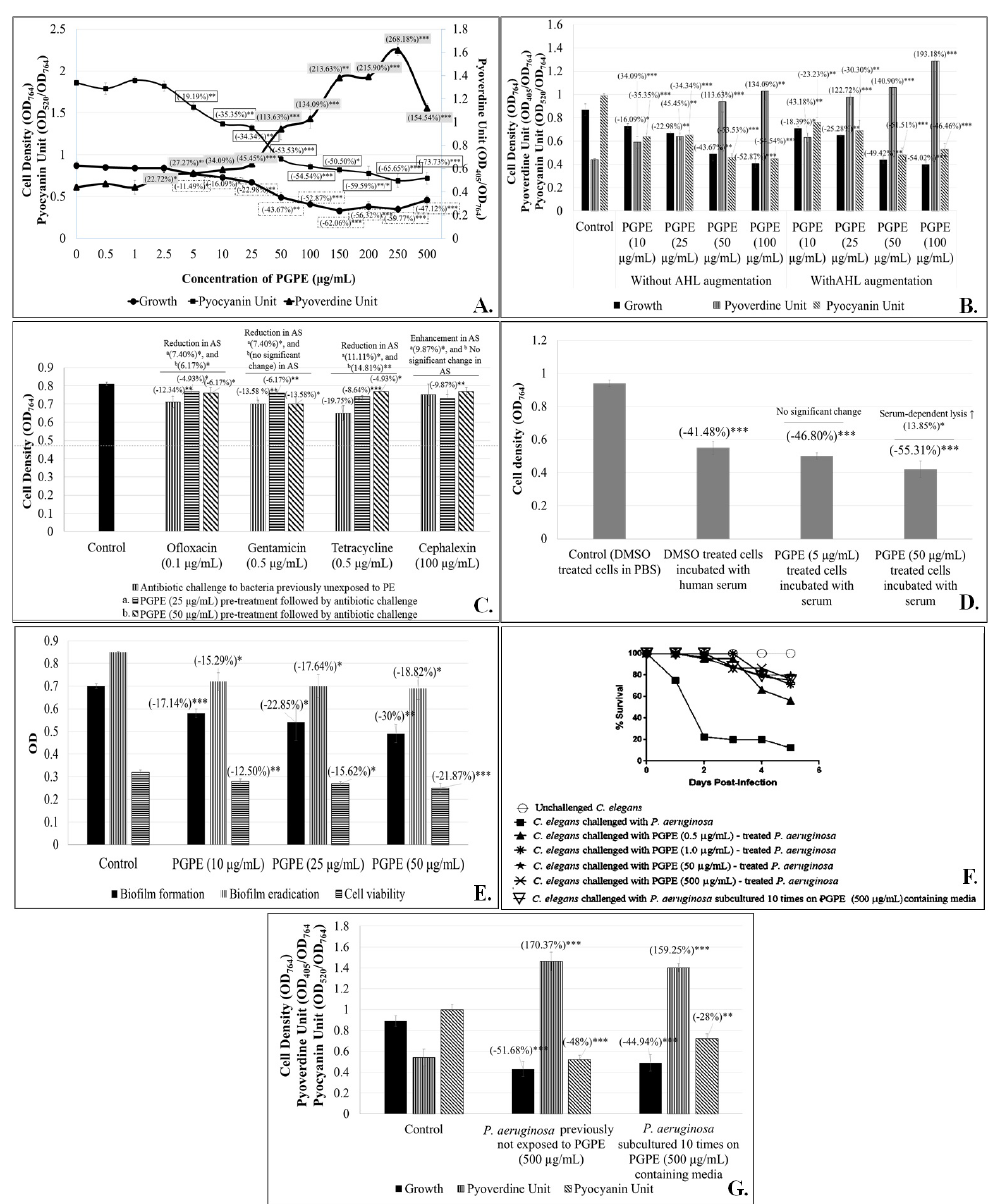
Figure 2. Effect of PGPE on various traits of P. aeruginosa, in vitro . ‘Control’ in this figure is the vehicle control (0.5%v/v DMSO), which did not exert any effect on growth and pigment production of P. aeruginosa . ( A ) Effect of PGPE on growth and QS-regulated pigment production in P. aeruginosa: Bacterial growth was measured as OD ; OD of pyoverdine was measured at 405 nm, and Pyoverdine Unit was 764 calculated as the ratio OD /OD (an indication of pyoverdine production per unit of growth), Pyocyanin Unit was calculated as the ratio 405 764 OD /OD (an indication of pyocyanin production per unit of growth); Catechin (50 µg/ml) inhibited pyoverdine and pyocyanin production 520 764 by 17.13±0.06% and 23.65±0.04% respectively, without affecting the bacterial growth. ( B ) PGPE acts as a signal-response inhibitor against P. aeruginosa . ( C ) P. aeruginosa challenged with antibiotics following pre-treatment with PGPE. ( D ) PGPE modulates susceptibility of P. aeruginosa to lysis by human serum: ‘Control’ in serum-dependent lysis assay was PGPE-unexposed cells of P. aeruginosa incubated with human serum. ( E ) Effect of PGPE on P. aeruginosa biofilm formation, eradication, and viability. Crystal violet assay was performed to measure biofilm formation, and biofilm eradication, followed by the measurement of OD at 580 nm; Cell viability in biofilm was estimated through MTT assay, wherein OD was measured at 560 nm. ( F ) PGPE-treatment reduces the virulence of P. aeruginosa towards C. elegans: Catechin (50 µg/ml) and gentamicin (0.1 µg/ml) employed as a positive controls conferred 100% and 80% protection on worm population respectively. Pre-treatment of bacteria with PGPE at concentrations (2.5, 5, 10, 25, and 100 µg/ml) other than shown in figure allowed 73.75, 75, 77.5, 77.5, and 75% worm survival respectively; DMSO present in the ‘vehicle control’ at 0.5%v/v did not affect virulence of the bacterium towards C . elegans; DMSO (0.5%v/v) and PGPE at tested concentrations showed no toxicity towards the worm. ( G ) Effect of PGPE on P. aeruginosa growth, Pyoverdine Unit, and Pyocyanin Unit remained unaltered after repeated exposure to PGPE (500 µg/ml). *p< 0.05 , **p< 0.01 , ***p< 0.001. AS, antibiotic susceptibility; QS, quorum sensing; PGPE, Punica granatum peel